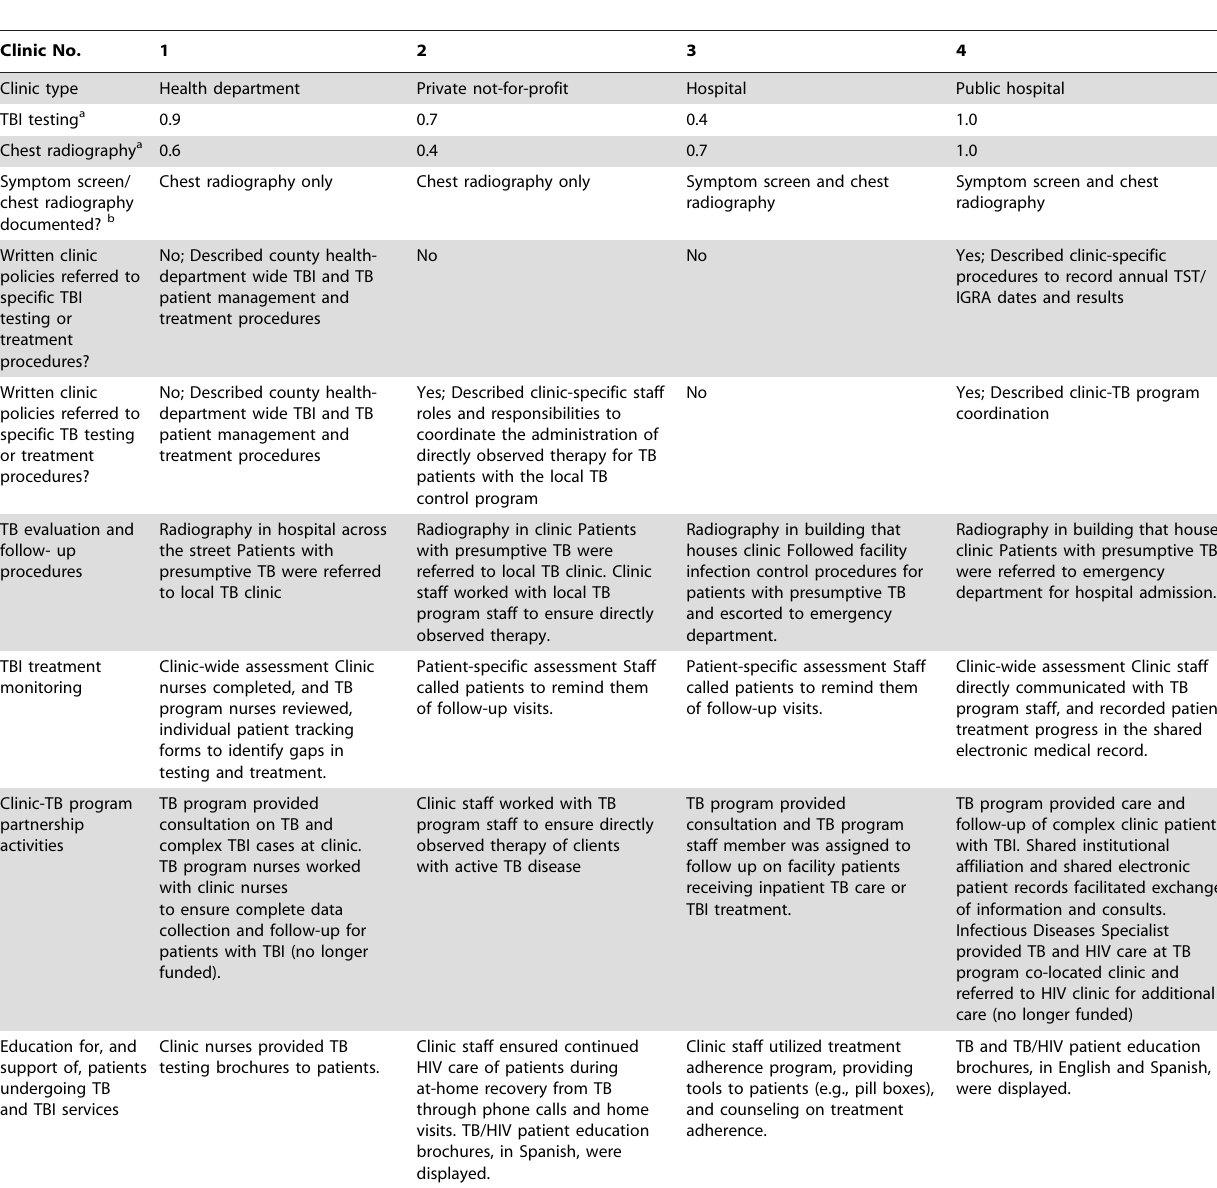
Table 4. Clinic-specific rates, policies, procedures related to TB services.